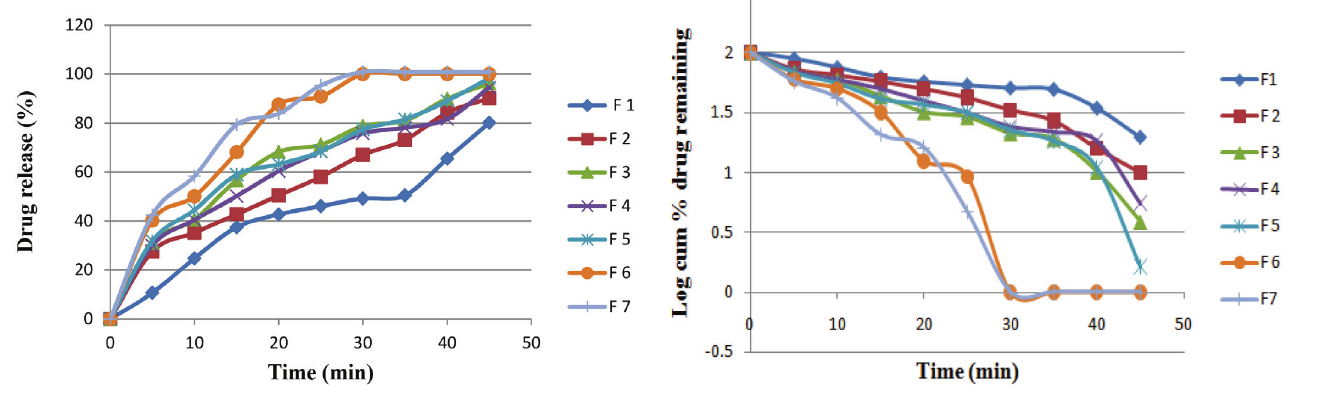
FIGURE 1 - Drug release (%) of formulations versus time (min). TABLE IV - Drug release kinetics (R 2 values of formulations)